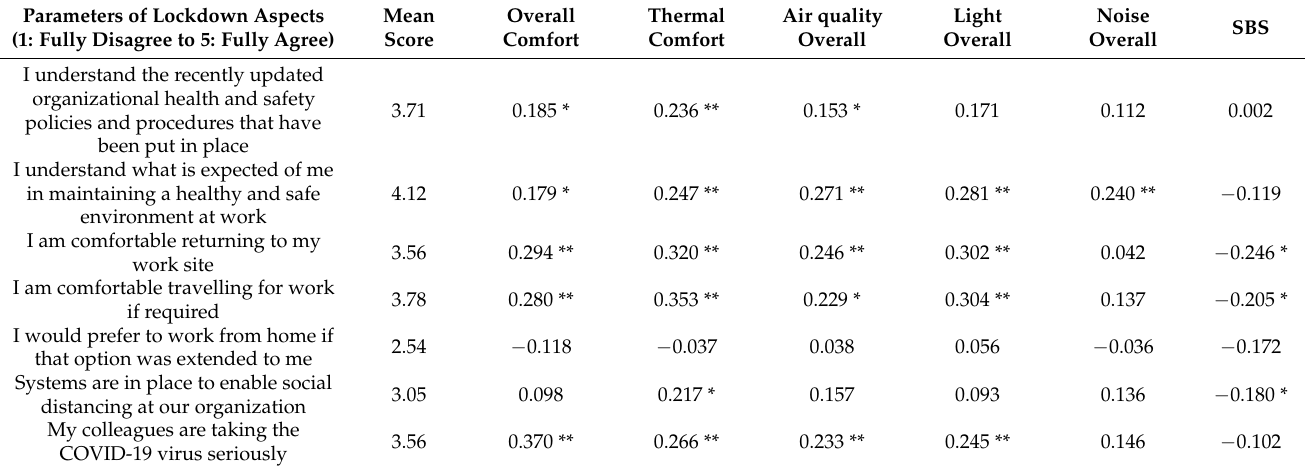
* Correlation is significant at the 0.05 level ** Correlation is significant at the 0.01